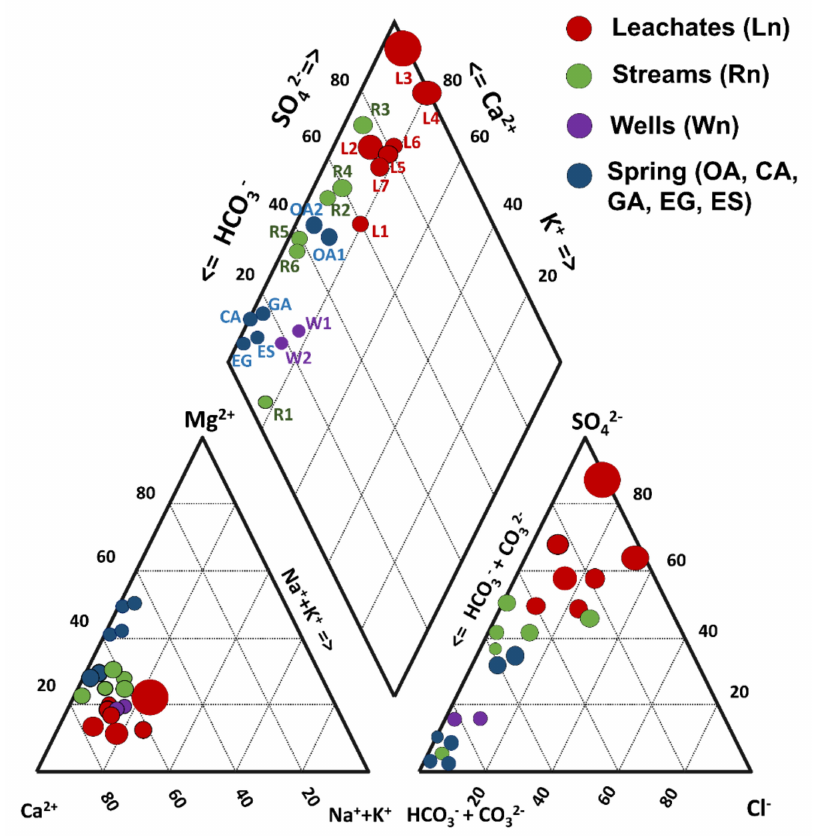
Figure 2. Piper diagrams for the different types of water present in the study area. The size of the marker increases as the EC concentration in the sample